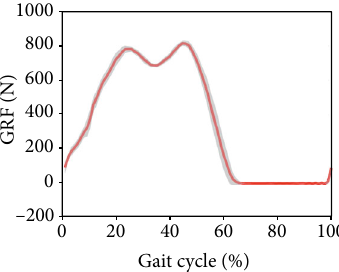
Figure 14: The mean (red) and standard deviation (shaded) of vertical GRF for the prosthesis user PRO1, trial 3, during the preferred walking speed of 0.8m/s. The mean and standard deviation are calculated over 30 gait